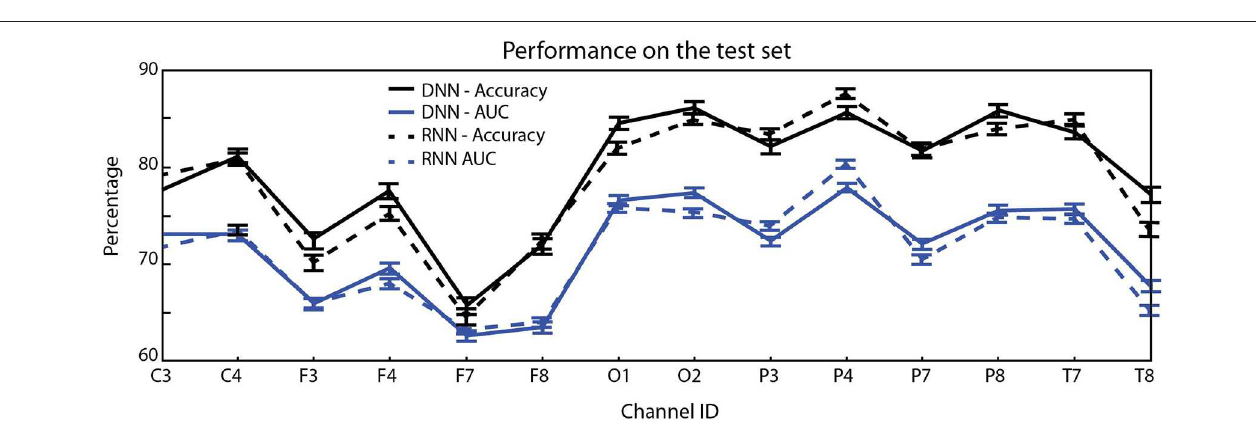
FIGURE 5 | Mean test accuracy (blue) and AUC (black) per EEG channel (averages and standard error of the mean evaluated over 2,000-folds) for the single channel HC vs. PD classification problem. Occipital and parietal electrodes provide better discrimination (top: DCNN architecture, bottom: RNN).